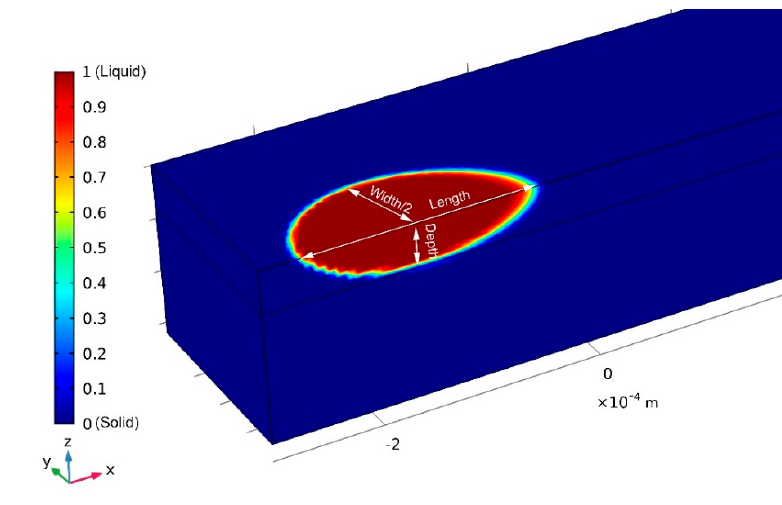
Figure 10. Schematic diagram of melt-pool size at 400 µ s and laser power at P = 100 W.